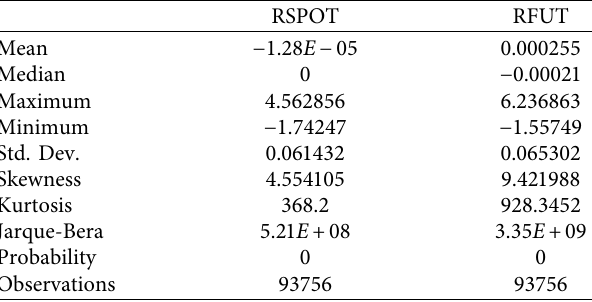
Table 1: Summary statistics for one minute log returns for the spot and futures markets.